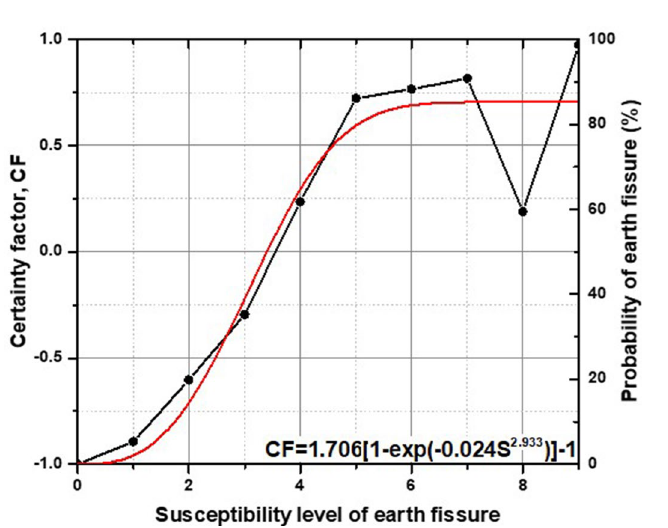
Figure 6. CF as a function of the level of